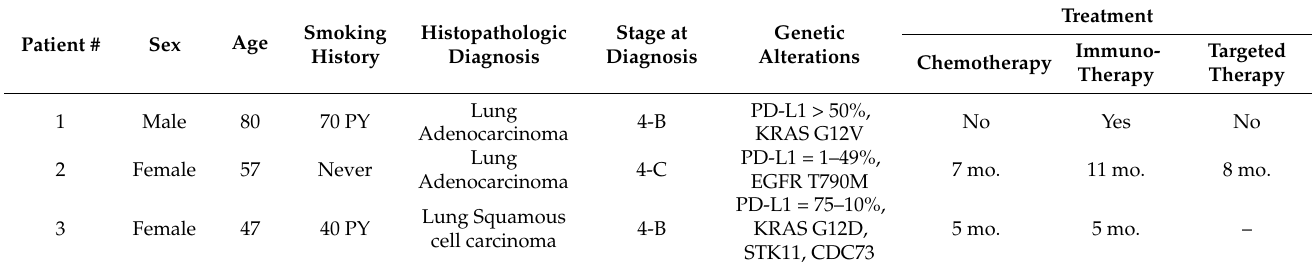
Table 2. Summary of Clinical History and Treatment Plan of Patients